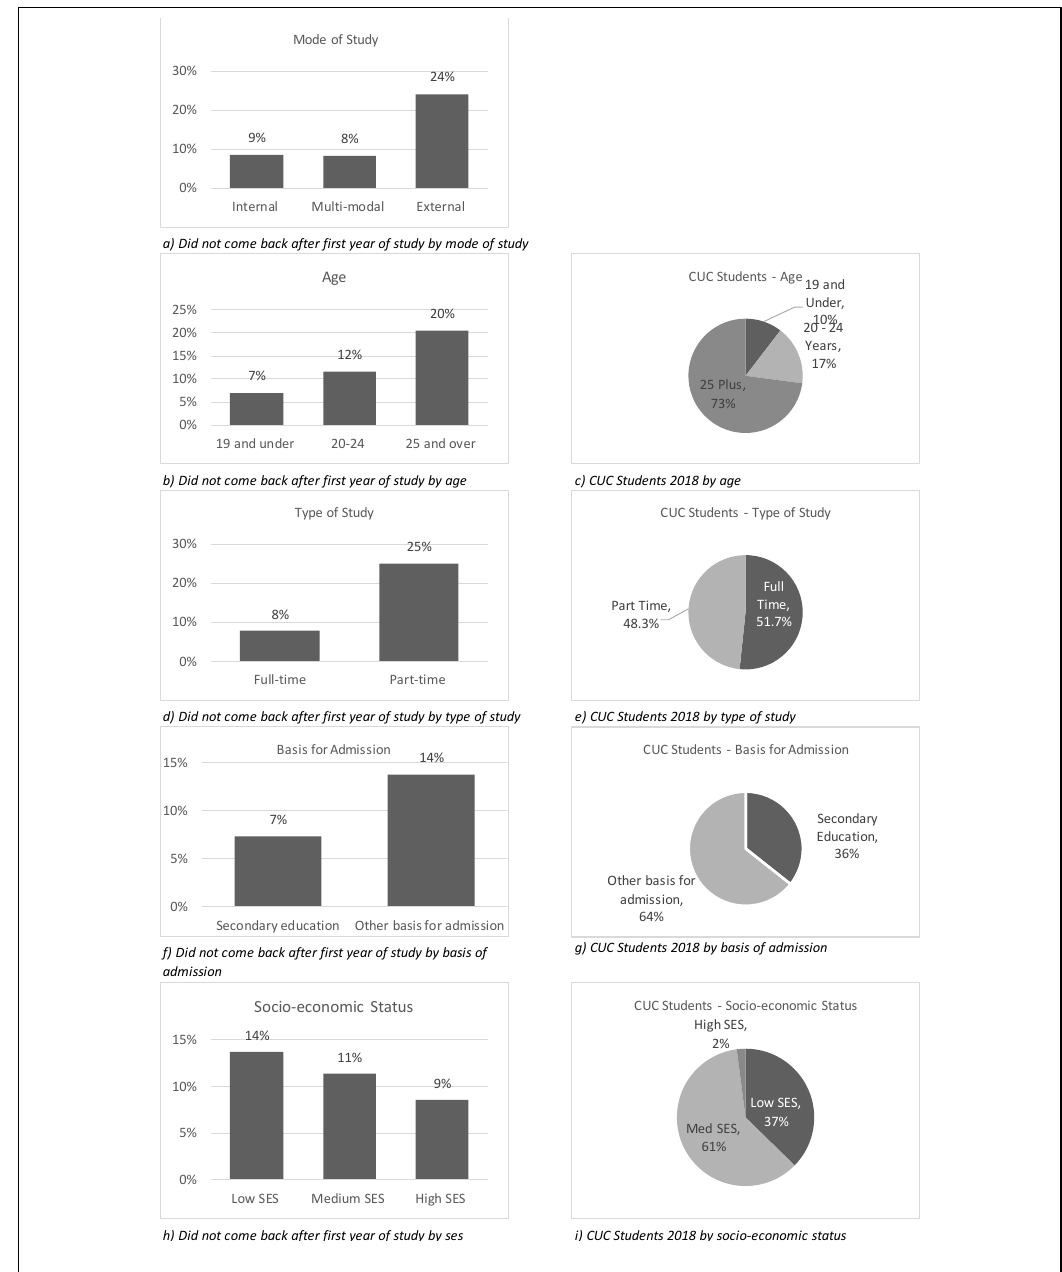
Figure 3. Student characteristics compared to first-year attrition rates. Australian student figures are presented on the left side, with CUC students on the